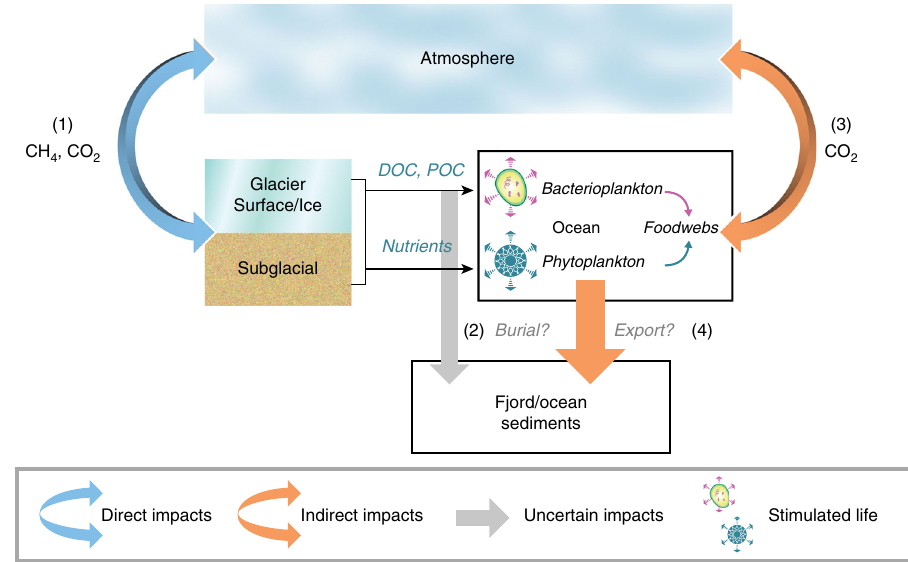
Fig. 1 Conceptual diagram of ice sheets in the global carbon cycle. The diagram indicates the potential direct and indirect impacts of ice sheets. (1) direct sequestration or emission of CO 2 /CH 4 by microbial activity in ice sheets, (2) burial of terrestrial OM exported from ice sheets by rivers, (3) emission of CO 2 by respiration or uptake by primary production in the oceans (4) export production – OM produced by primary production which is not recycled before it sinks to the ocean fl